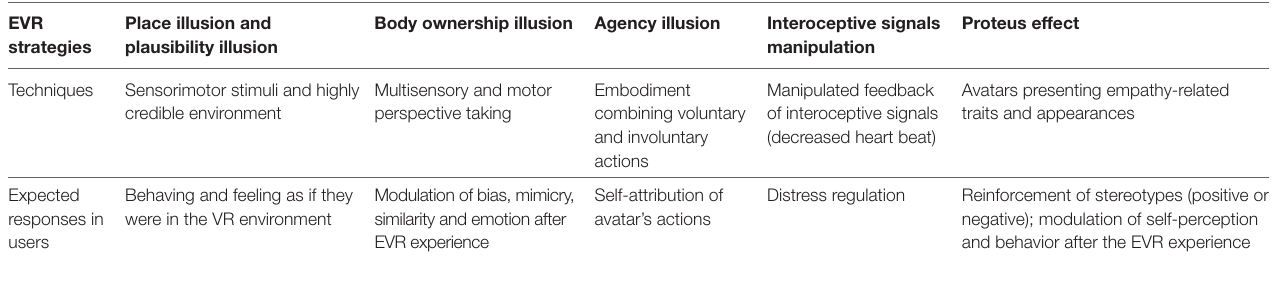
TABLe 5 | Highlighted concepts of embodied virtual reality that can be used for empathy-related